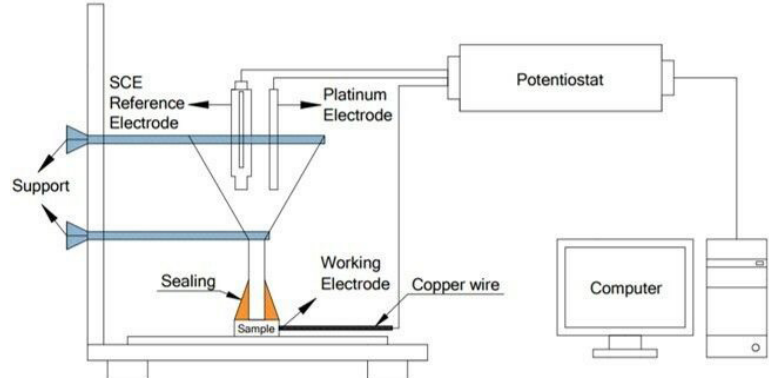
Figure 2. Experimental setup for the electrochemical potentiodynamic measurements.